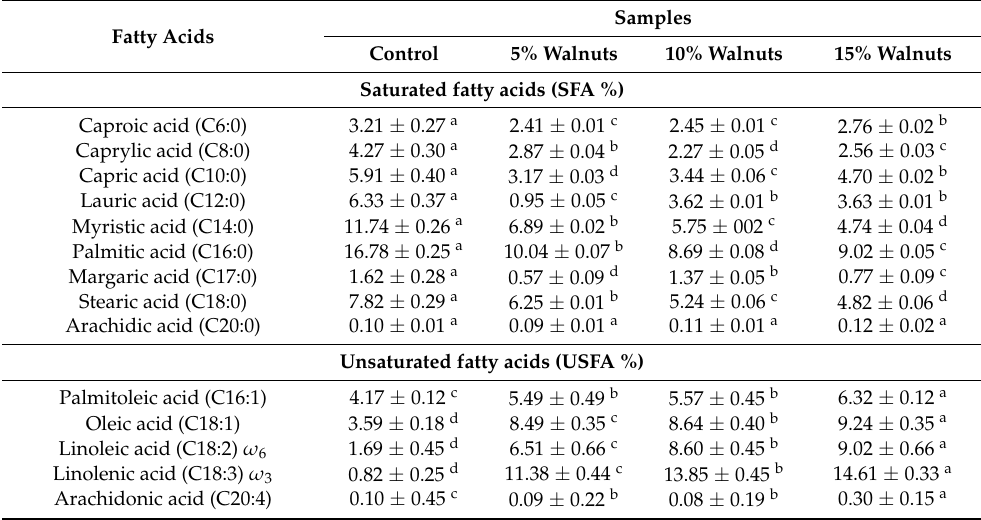
Table 2. Fatty acids profile of processed cheeses containing 0, 5, 10, and 15% walnut paste. Samples Fatty Acids Control 5%